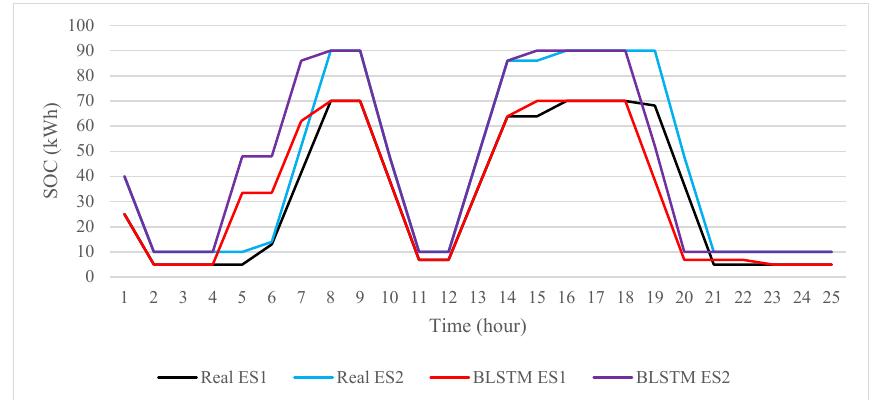
Figure 6. SOC of ESs with real data and BLSTM method.